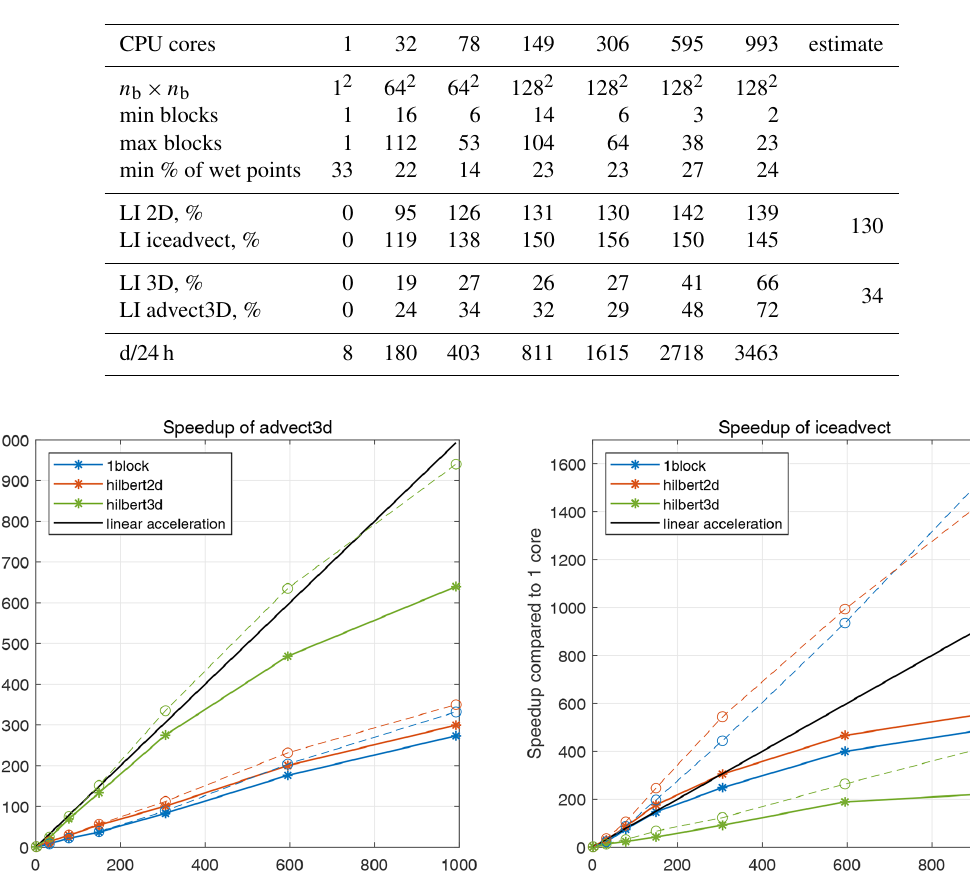
Table 4. Same as Table 2, but for the hilbert2d3d partition; “estimate” is given in Appendix B.